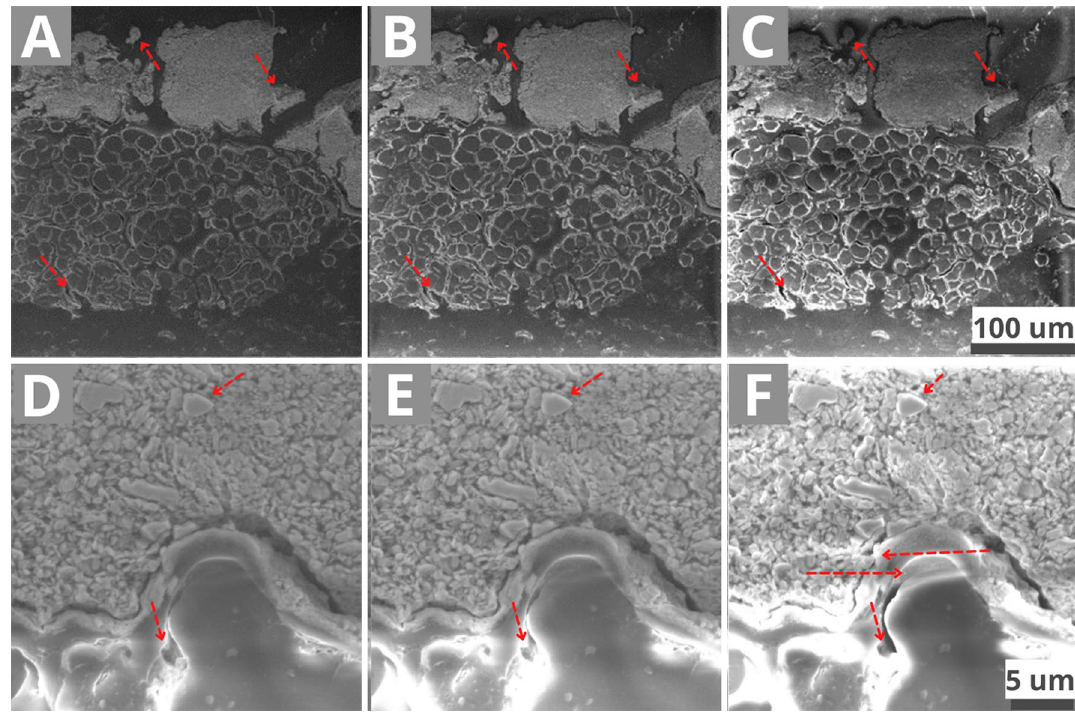
Figure 8. RS1 reference at 10 kV average magnification (801 x) WD 14 mm (A) 50 Pa vacuum marked as 1— low charging. The image contrast is relatively homogeneous, and the image is relatively stable. (B) 20 Pa vacuum marked as 2—Medium charging. Some parts of the pictures are becoming bright or dark (red arrows), the image contrasts are less homogeneous, and the image is unstable. (C) 15 Pa vacuum marked as 3—High charging. Very bright or dark parts hiding details of the sample appear, the image contrast is inhomogeneous, and the image is highly unstable (drifting). The contrast manager cannot smooth the differences. RS1 reference at higher magnification (10 kx) (D) 50 Pa 1—low charging. Some parts are charging (organic and resin; uneven brightness (Fig. 1A), but the image quality stays acceptable. (E) 20 Pa 2—Medium charging. Most details are invisible due to the increasing uneven brightness and the contrast of the inorganic material increases (red arrows). The image drifting increases. (F) 15 Pa 3—High charging. The uneven brightness is now on all materials. Bright lines (horizontal arrows; Fig. 1B) and a blurred image can also be